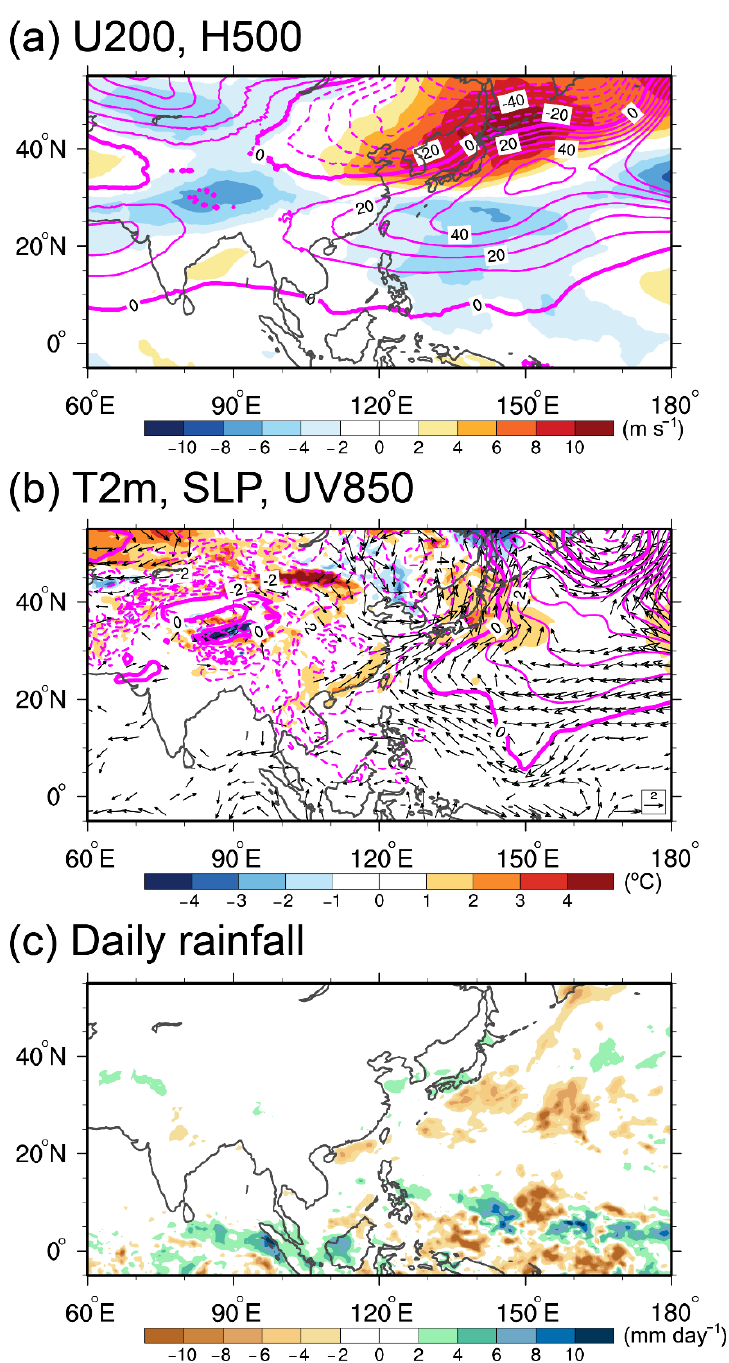
Figure 13. The differences between MPAS and CFSR in February 2014 for ( a ) U200 and H500, and ( b ) T2m, SLP, and 850-hPa winds. ( c ) Averaged daily rainfall difference between MPAS and GPM-retrieved rainfall in February 2014.